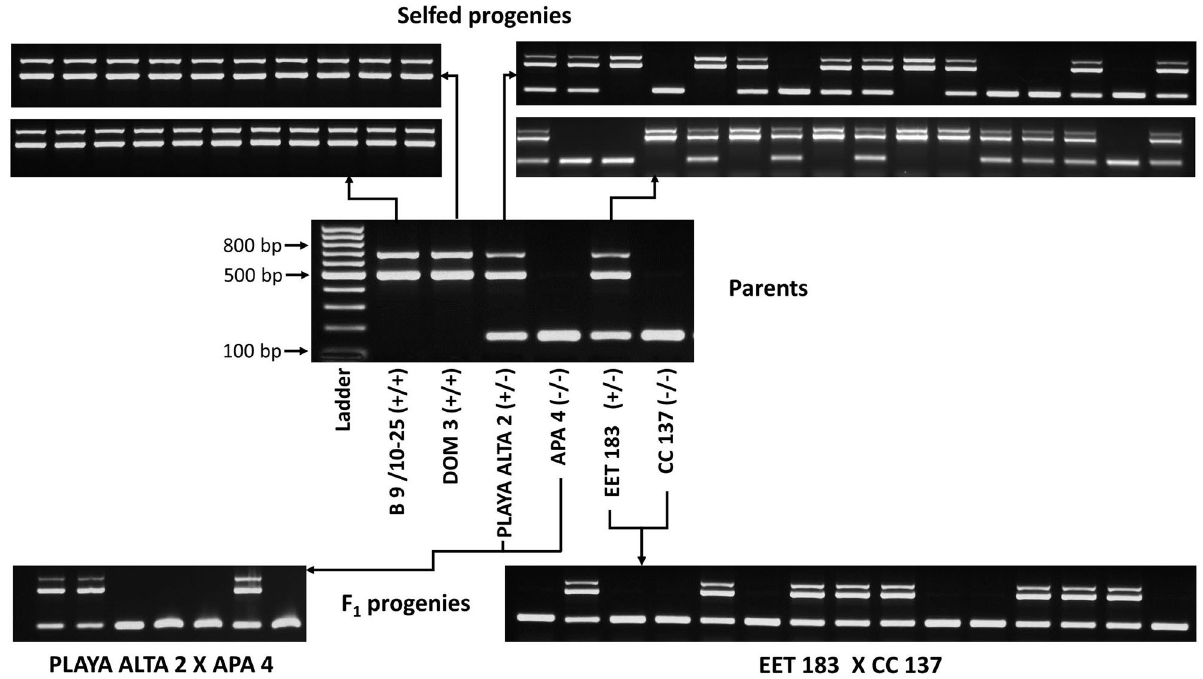
Figure 5. Segregation of viral type VI locus in selfed and crossed progenies of cacao clones. The parents and progenies were genotyped using a multiplex PCR assay including four primers (i.e. PA 279 Host F1, PA 279 Ins R, PA 279 Ins F and PA 279 Host R3).The 495 and 679 bp fragments represent virus + allele, left and right virus/ host genome junctions, respectively. The presence of one 142 bp fragment represents virus–allele (−/−), lacking viral insertion. The presence of both 495 and 679 bp fragments in a genotype represents homozygous status (+ / +) of the virus insertion locus, whereas amplification of 142, 495 and 679 bp fragments indicates hemizygous status (+ /−) of the viral insertion locus. Full-length gels are presented in Supplementary Figs.